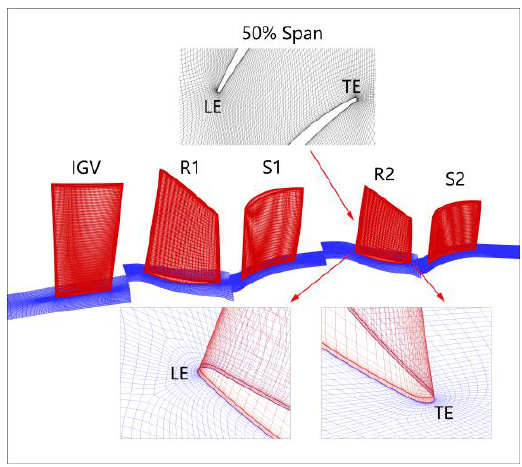
Figure 3. Grid topology for the highly loaded compressor.